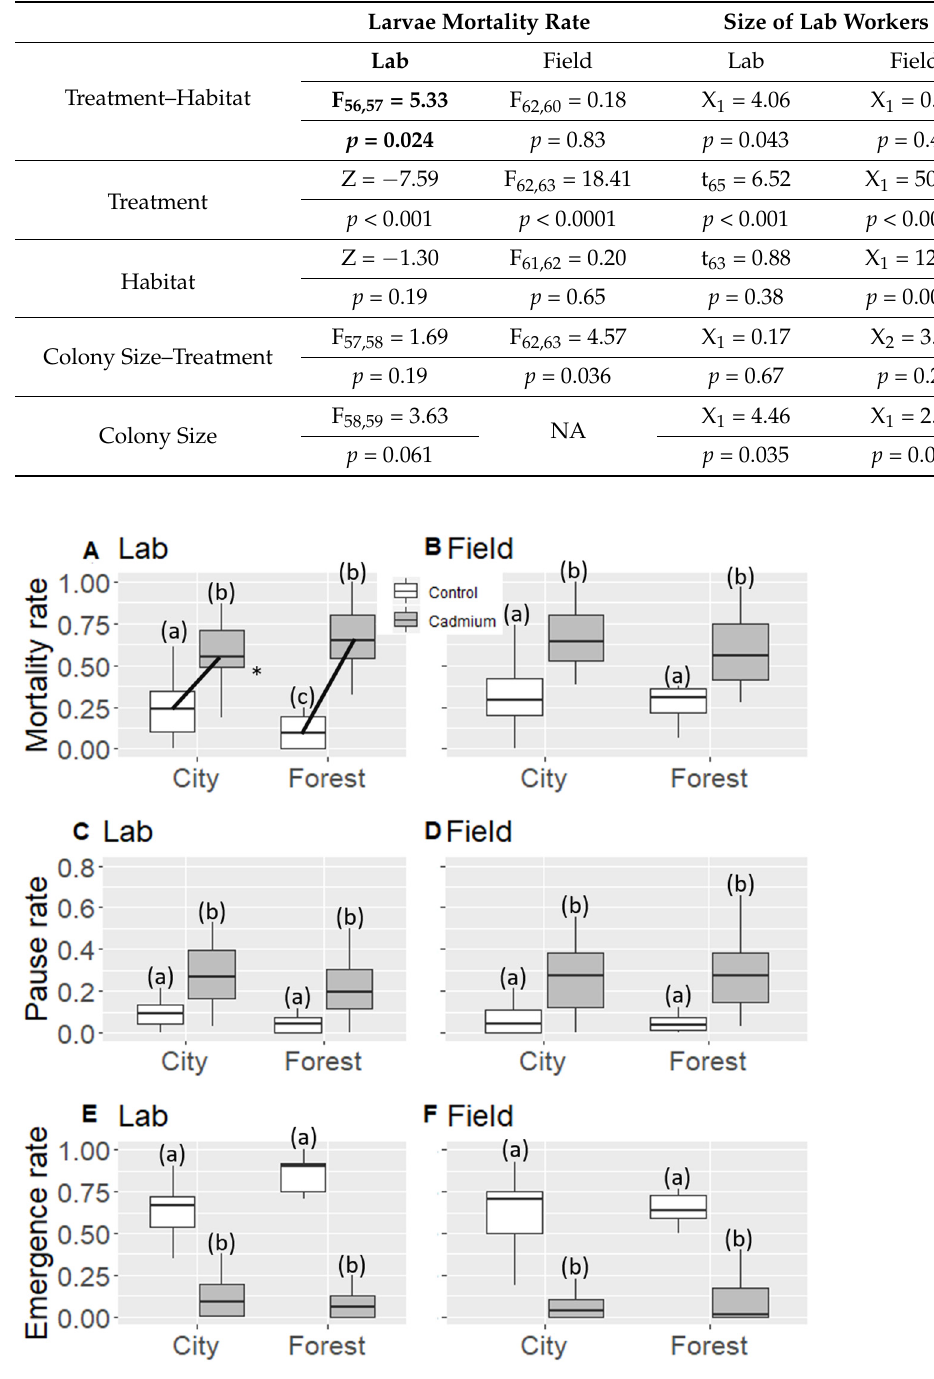
Figure 2. Mortality, larval paused development, and emergence rate of larvae for lab ( A , C , E ) and field hibernation conditions ( B , D , F ). White: control treatment, gray: cadmium treatment. For each box, median and quartiles are shown. (*) shows a significant double interaction. Black lines denote the double interaction. Different letters represent significant differences for each lines (a, b).